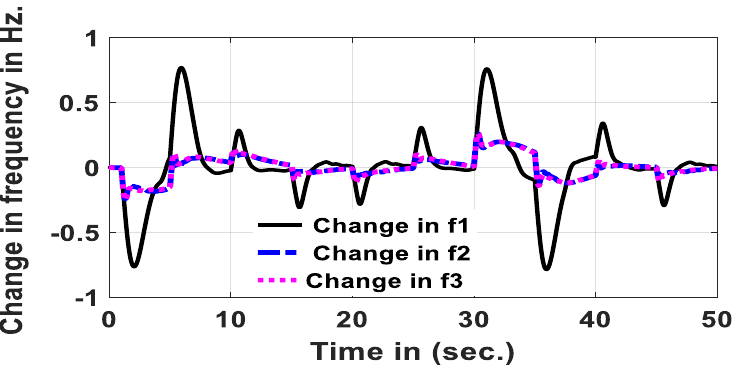
Figure 19. Random load change pattern in the range of [ − 0.2 to 0.2].